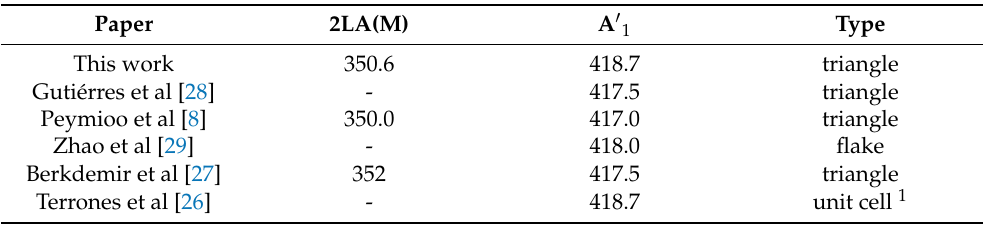
Table 1. Comparison of Raman shift (cm − 1 ) obtained in this work with their counterparts of different types of WS 2 samples reported in the